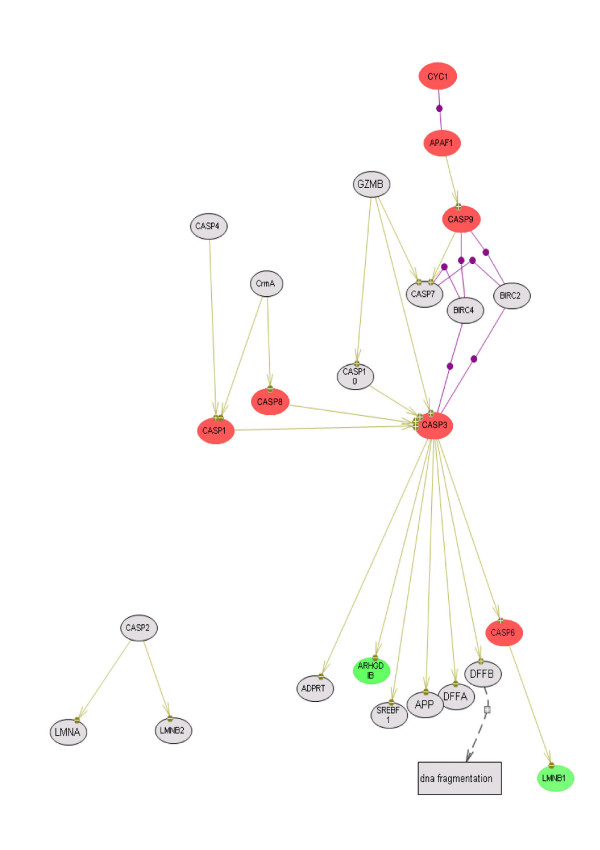
Pathway-analyses based on decreased (green) and increased (red) genes detected in fibrosarcoma cells after 24 h treatment with doxorubicin. Results shown for caspases. Signaling pathway maps were identified using the software package Pathway Assist. A minimum of 3 interacting genes is the required criteria for creation of a map (Software: Pathway Assist™ Stratagene).